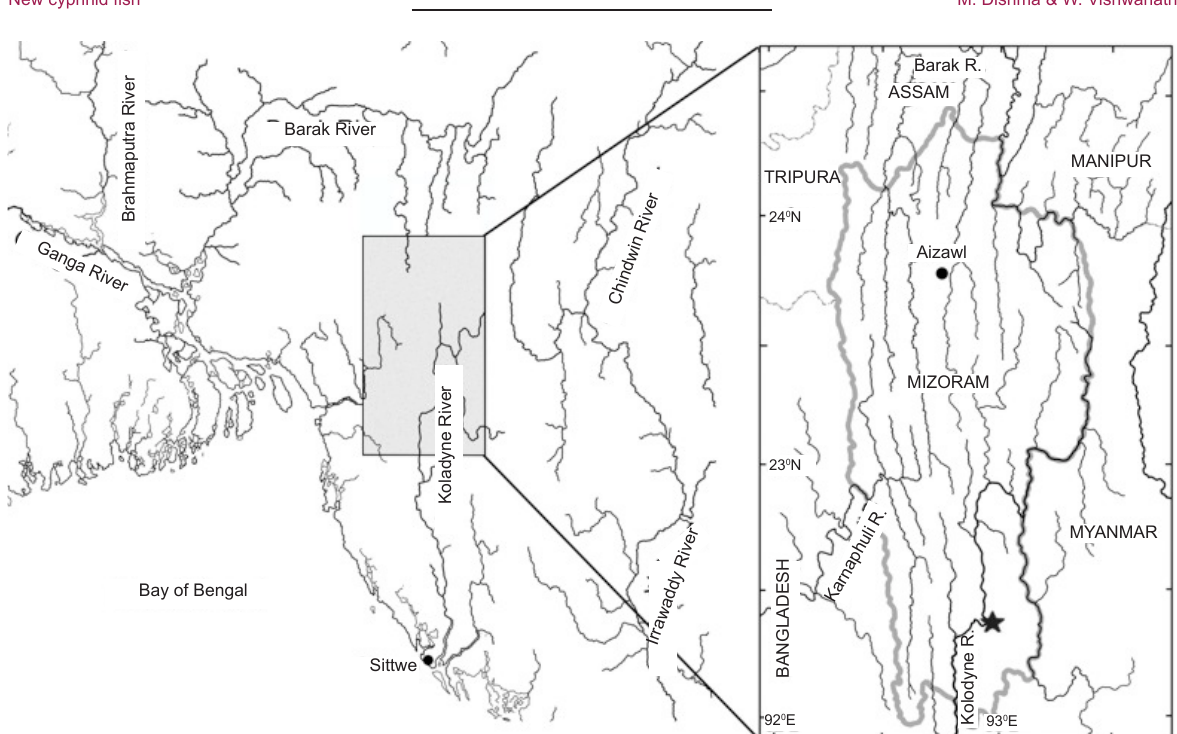
Figure 1. Map showing type locality of Barilius profundus sp. nov. indicated as a